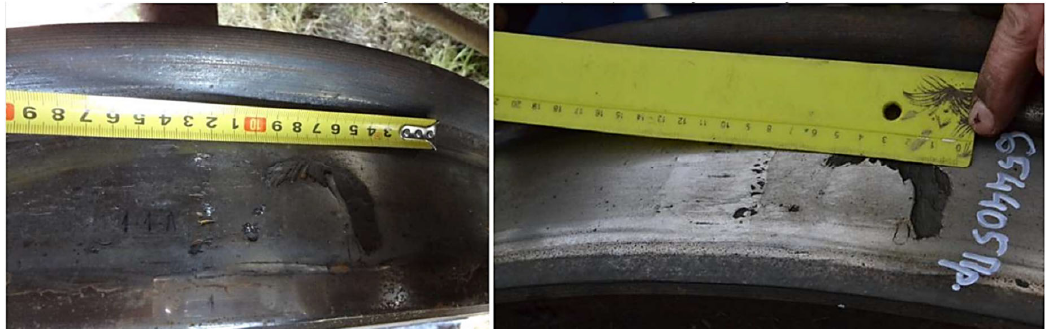
Figure 10. Two cracks in the wagon’s first wheelset wheel. Box and whisker values of the maximal vertical forces of loaded goods wagon are shown Figure 11.